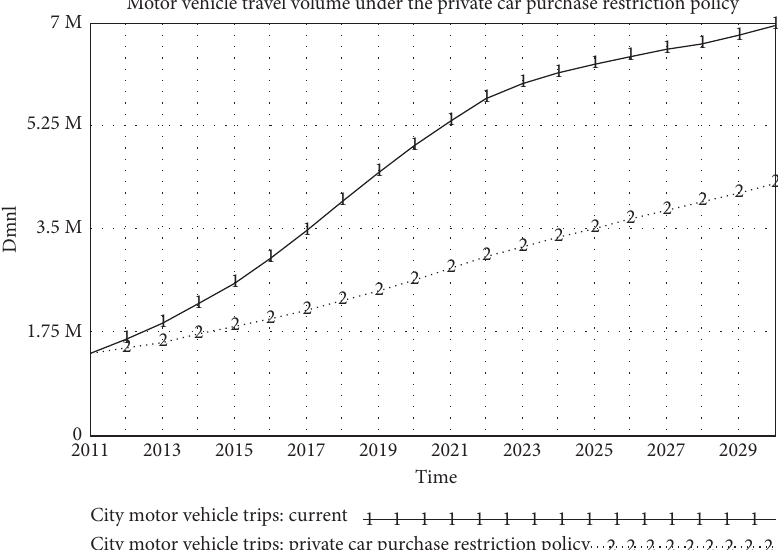
Figure 10: The number of motor vehicle trips in the city under the swaying policy.